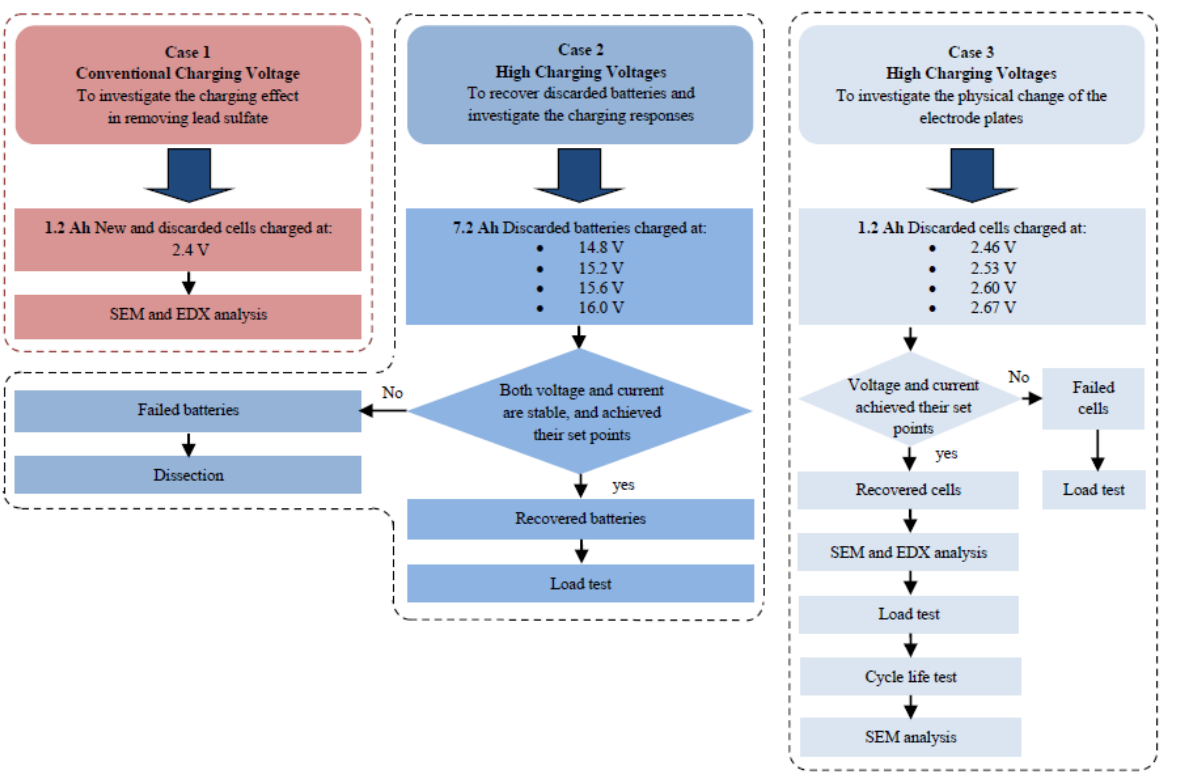
Figure 1. Experimental procedures for discarded cells and batteries.